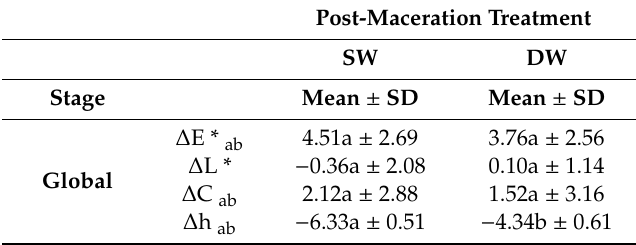
Table 4. Color di ff erences between SW and DW with respect to CW (SW 120 vs. CW 120 and DW 120 vs. CW 120 ) at the end of the stabilization stage. For each parameter, di ff erent letters in the same row indicate statistical di ff erences (Tukey test, α =